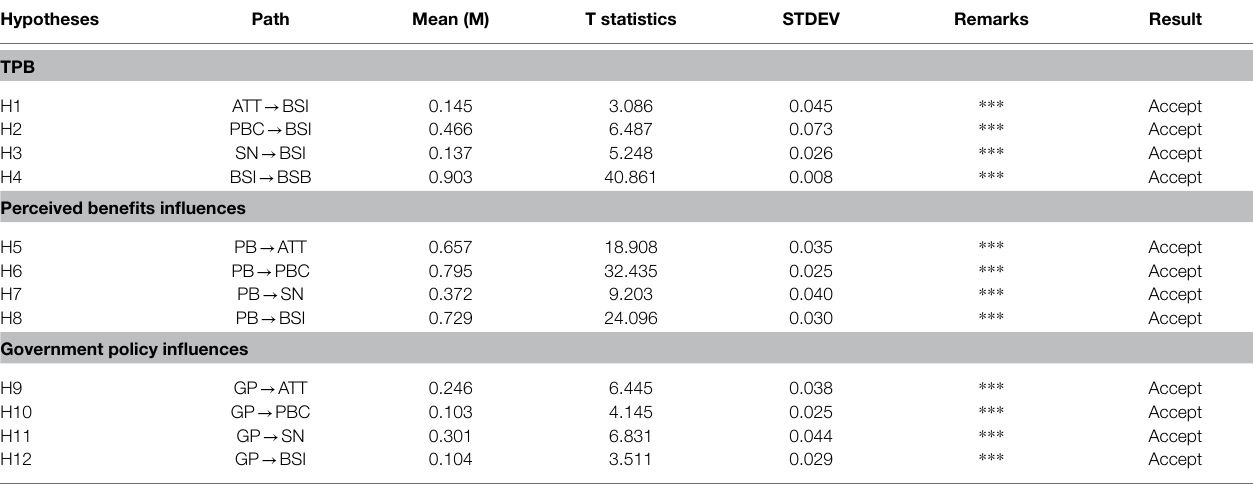
TABLE 5 | Result of the hypotheses